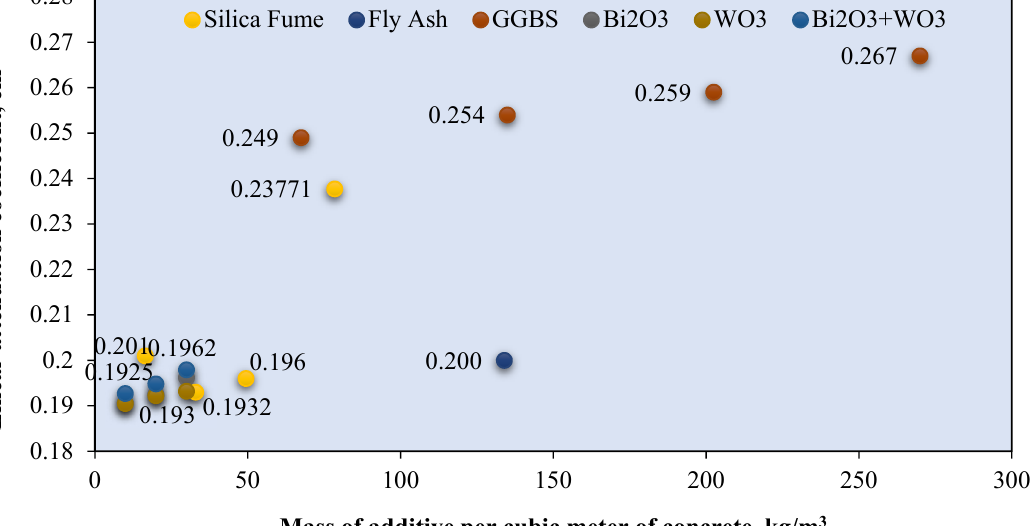
Figure 10. Relationship between linear attenuation coefficient (cm − 1 ) and amount of additives in concrete (kg/m 3 ) (data adapted from [14,44,63,95,122,128]).